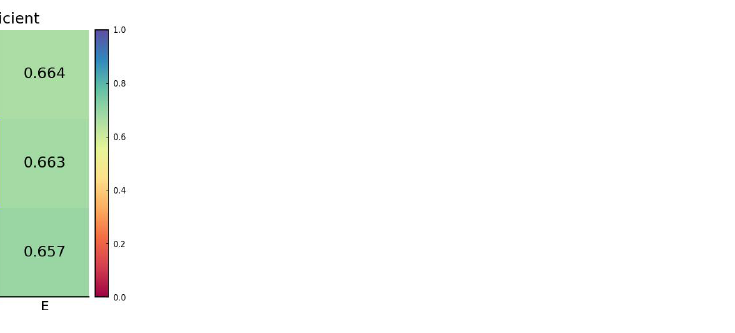
Figure 7. Correlation coefficients of CMF in Berlin with its eight neighboring grid cells.